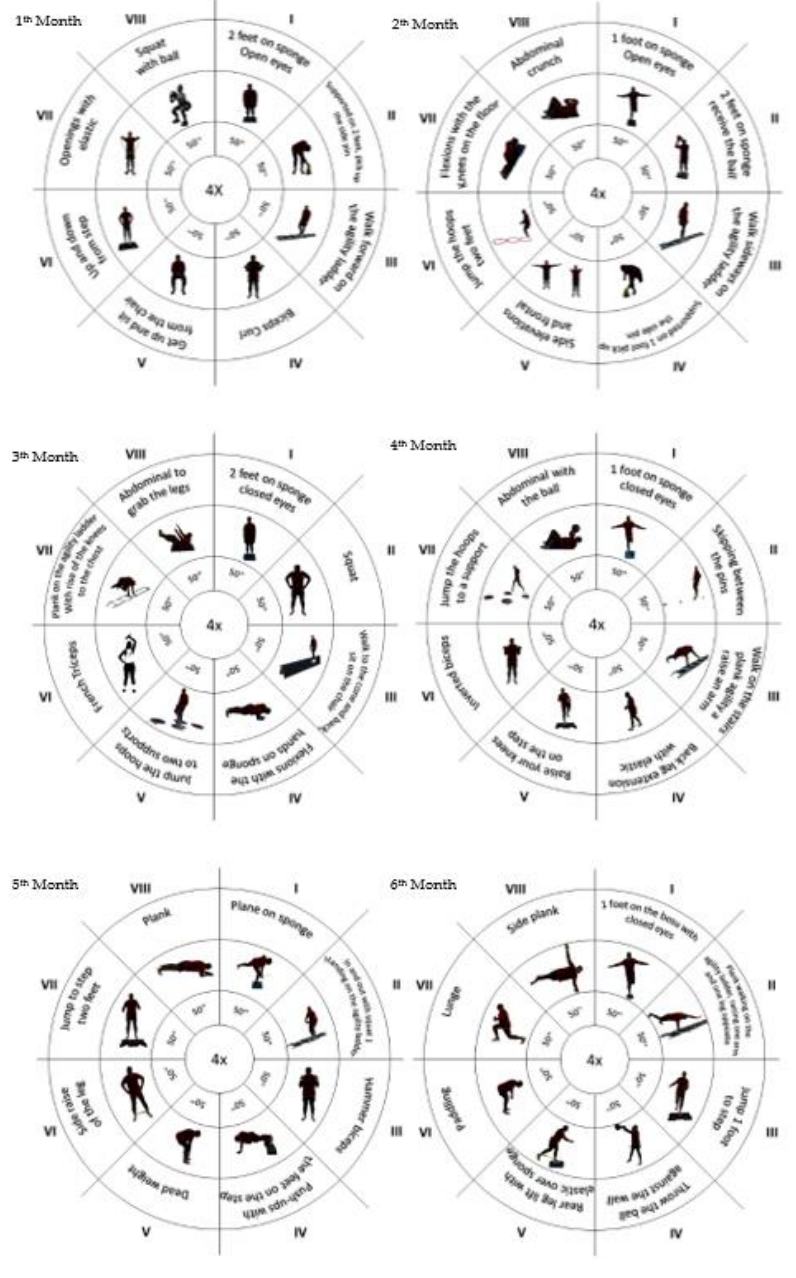
Figure 2. Sessions ’ main part planning. Figure 2. Sessions’ main part